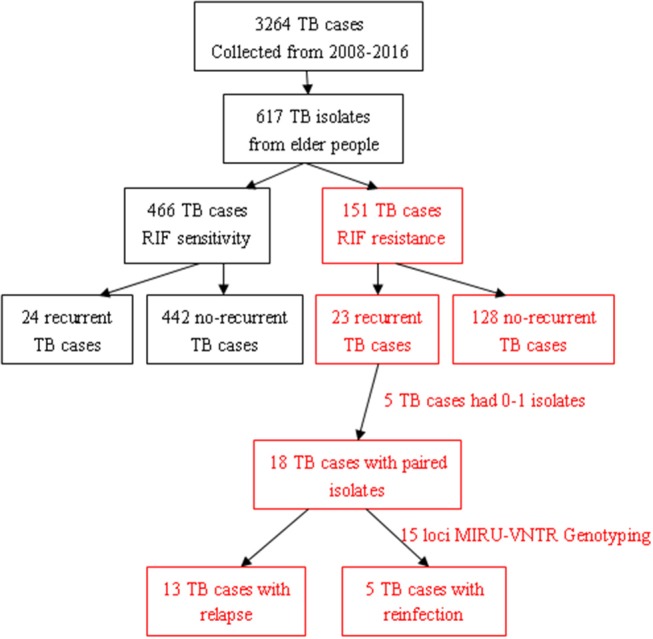
Flow diagram of tuberculosis (TB) cases in this study.